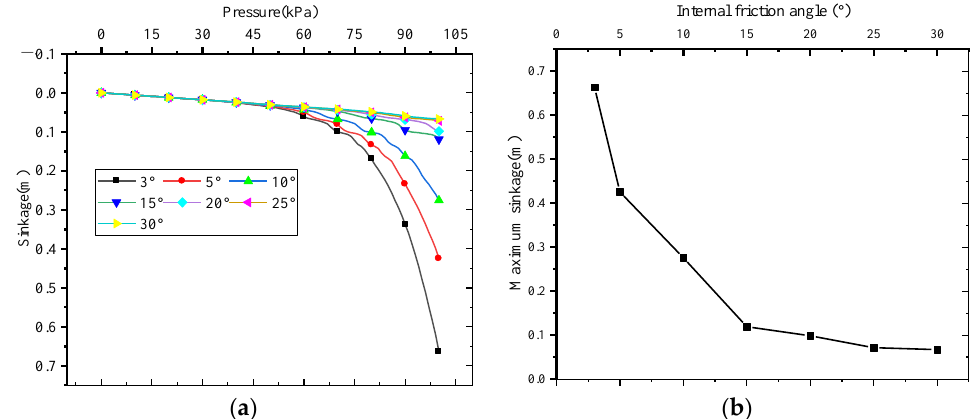
Figure 26. ( a ) Pressure-sinkage curves of different IFA and ( b ) maximum sinkage comparison at 100